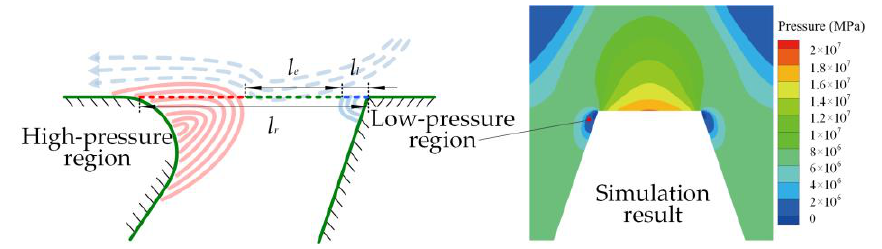
Figure 7. Effective impact width of the receiver.